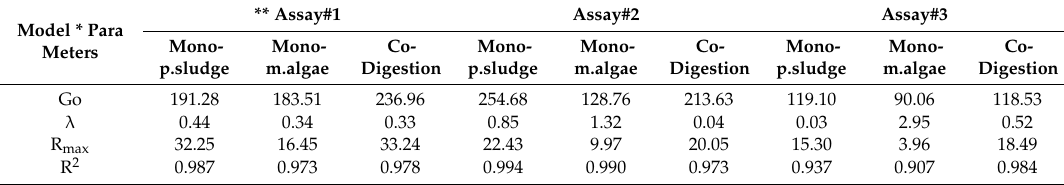
Table 2. Kinetic model parameters for di ff erent assays (no pretreatment